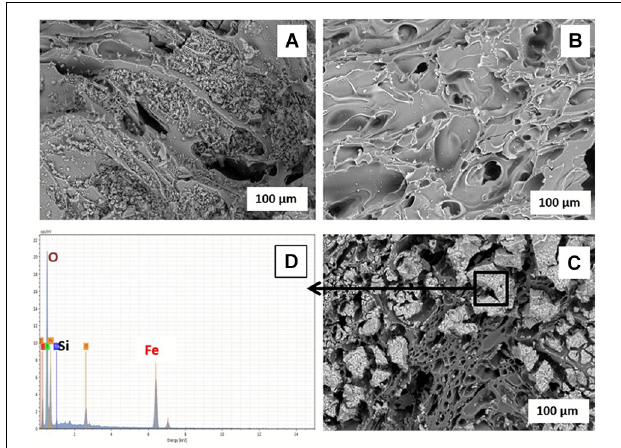
FIGURE 2 | ESEM micrographs of (A) unwashed uncoated pumice, (B) acid-washed uncoated pumice, (C) akaganeite (Fe(III)-coated pumice, and (D) EDS spectrum of Akaganeite-coated